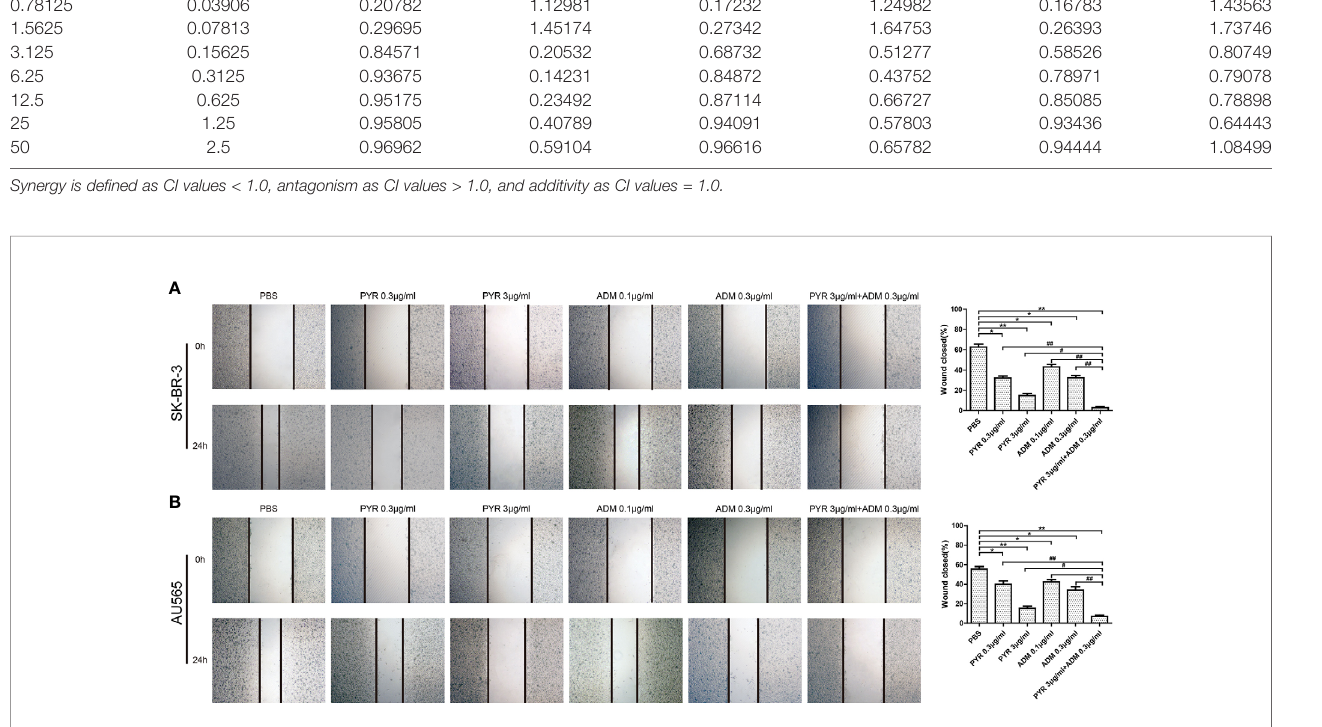
FIGURE 2 | Effects of PYR and ADM on cell migration. The monolayers of SK-BR-3 and AU565 cells were scratched with a pipette tip, and incubated with PBS, different concentrations of PYR (0.3, 3 m g/ml), ADM (0.1, 0.3 m g/ml) or a combination treatment (PYR+ADM) for 24 h. (A) Wound healing assay assessed the effect of PYR and ADM on SK-BR-3 cell migration ability and histogram represents the statistical analysis. (B) Wound healing assay assessed the effect of PYR and ADM on AU565 cell migration ability and histogram represents the statistical analysis. Original magni fi cation was ×100. Data represent the mean ± S.D. of three independent experiments. *p<0.05 and **p<0.01 compared with the PBS group, # p<0.05 and ## p<0.01 compared with the combination group.